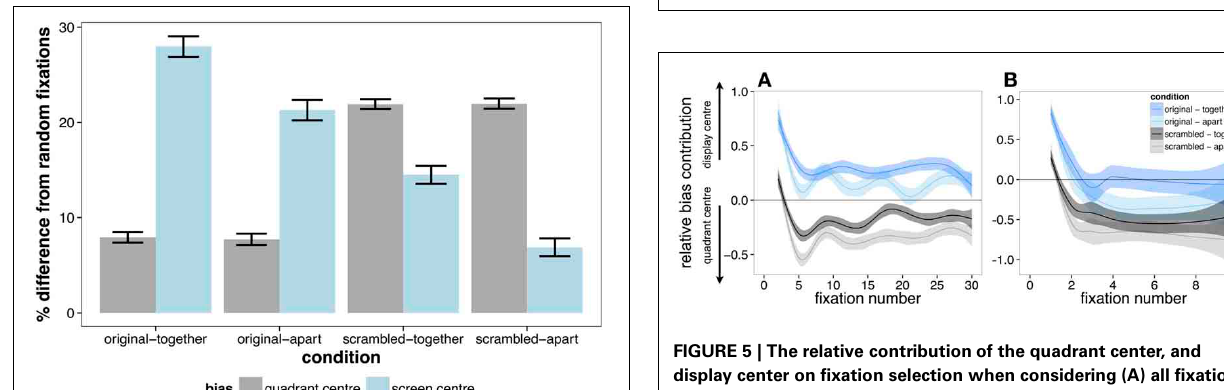
FIGURE 4 | Visualization of differences in fixation distributions between original and scrambled scenes. Red areas indicate areas of higher fixation numbers in the scrambled versions of the scenes.